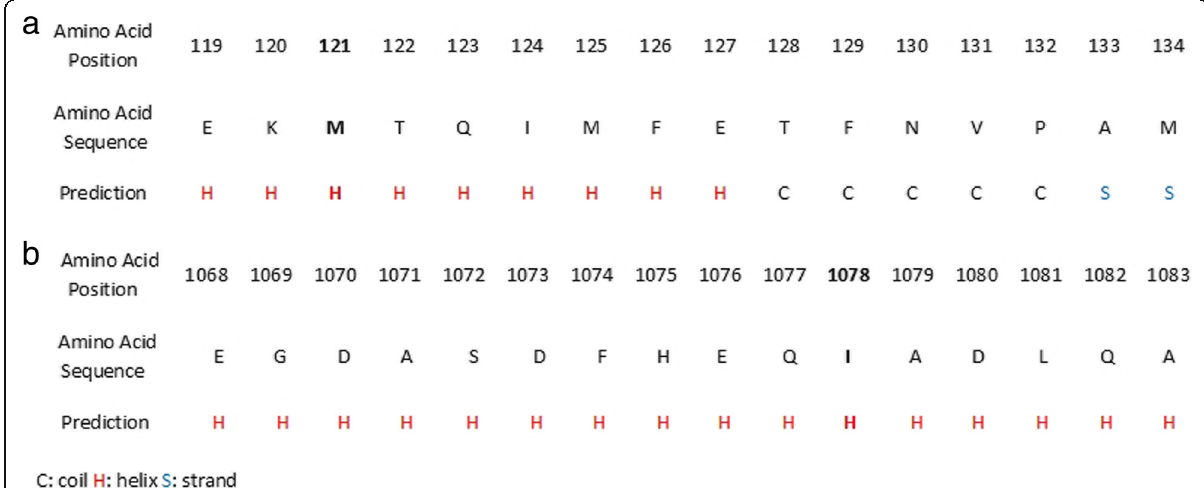
Fig. 2 The predicted secondary structure of a . ACTA2 and b . MYH11 proteins indicating, the location of the amino acids Met121 (bold) and Ile1078 (bold) respectively, on a helix structure where the variants (p.Met121Ilefs*5) and (p.Ile1078Met) occur using I-TASSER